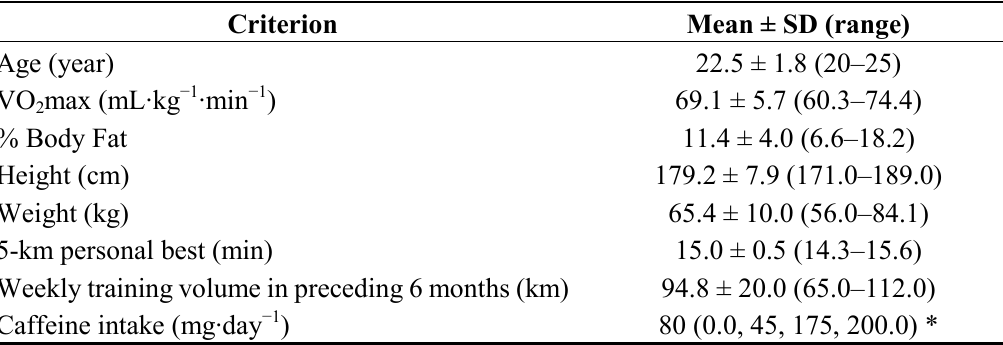
Table 1. Demographic data for subjects ( n =